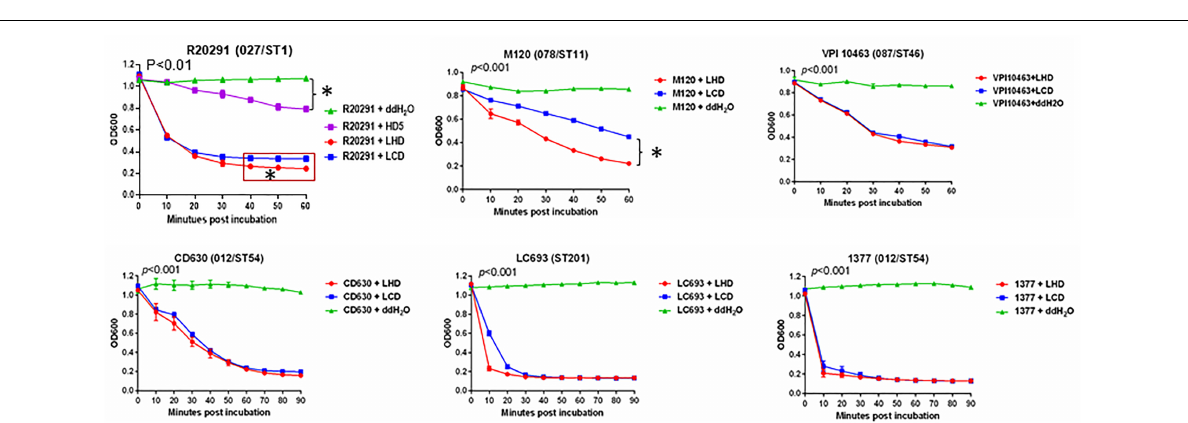
FIGURE 3 | Lytic activity of LHD on different types of Clostridioides difficile strains. The lysin catalytic domain LCD was included as a control. In strain R20291, HD5 was also included as a control. Lytic activity of LHD was significantly higher than that of LCD at the time points marked in red boxes ( ∗ p < 0.05). p < 0.001 between groups “ C. difficile strain+LHD” and “ C. difficile strain+H 2 O”. Data are present as “Mean ± SD”. Experiments were repeated 3 times, and representative data were